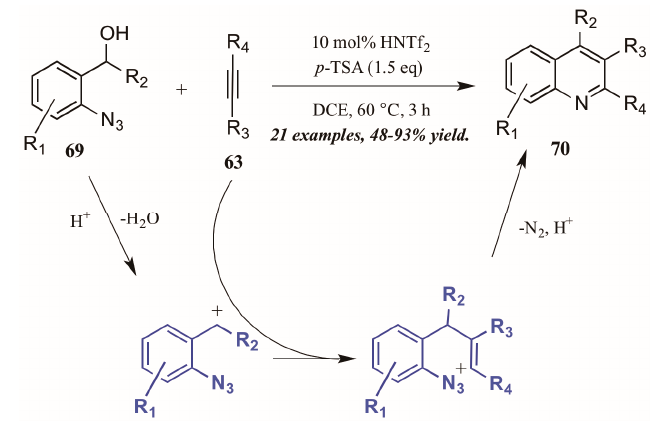
Figure 31. Acid-mediated cyclization of arylazides with alkynes.